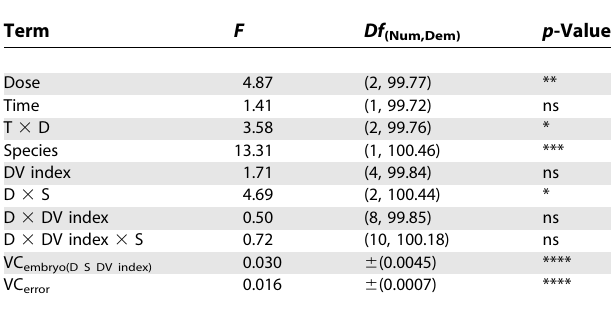
Table 1. ANOVA on EVE Abundance in Stripe 2 from D. erecta and D. pseudoobscura S2E Rescue Constructs